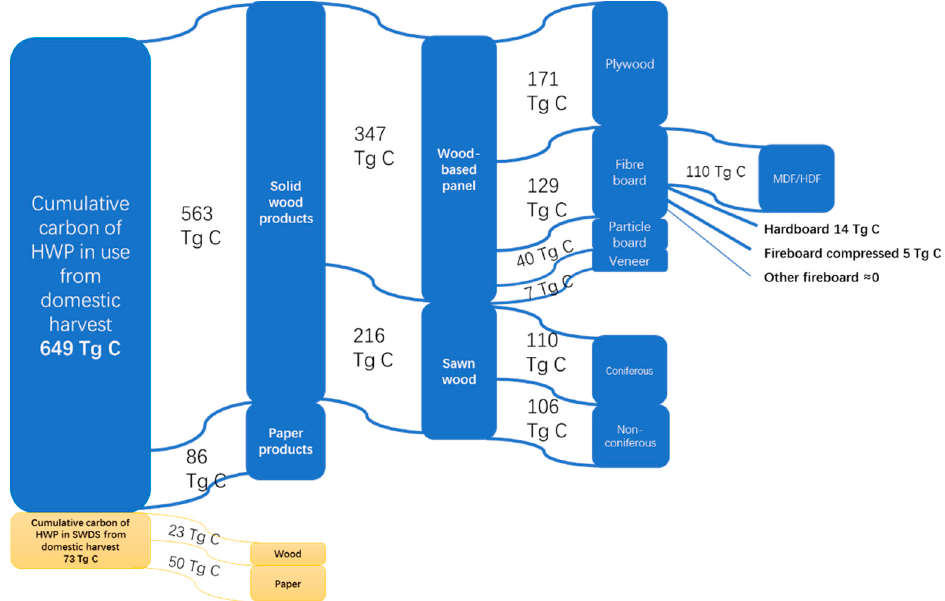
Figure 3. Carbon contribution by different categories including HWP in use and waste from domestic harvest in China, the period of cumulative carbon stock is from 1900 to 2016.